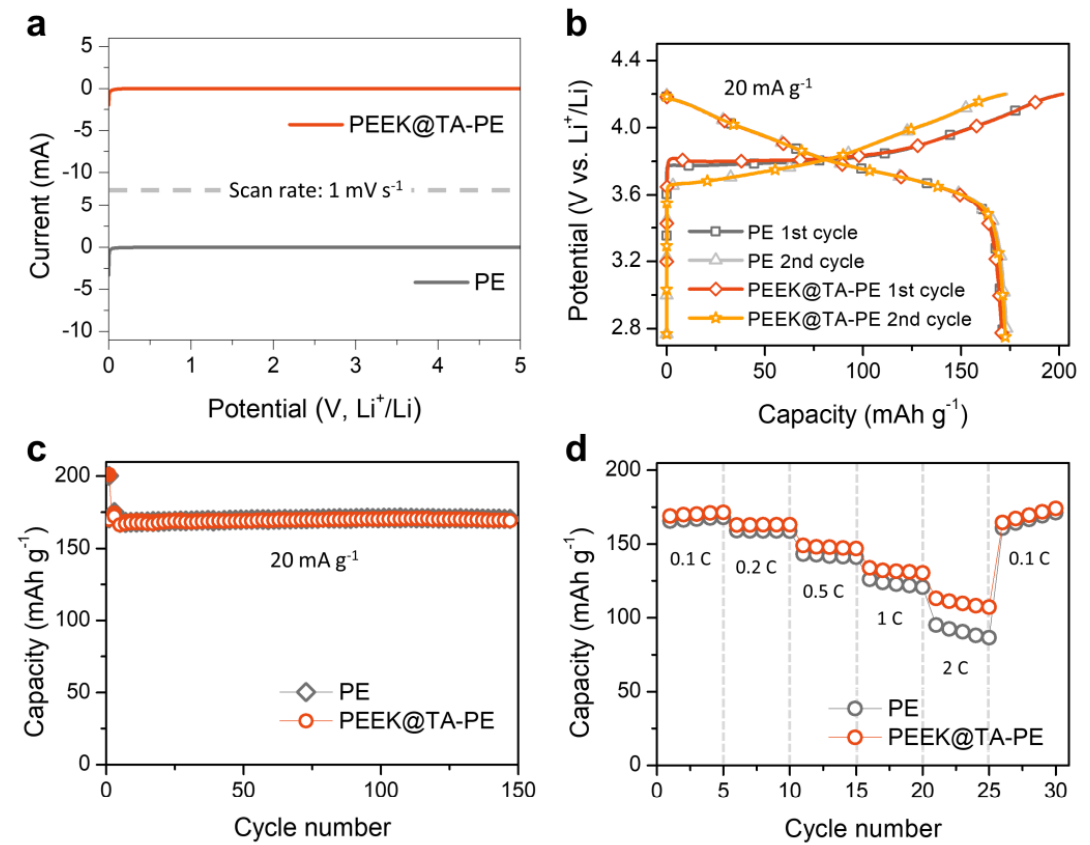
Figure 8. Electrochemical properties: ( a ) LSV curves, ( b ) voltage profiles at 20 mA g –1 (0.1 C), ( c ) cycle performance at 0.1 C, and ( d ) rate performance of the cells with the PE and PEEK@TA-PE separators.